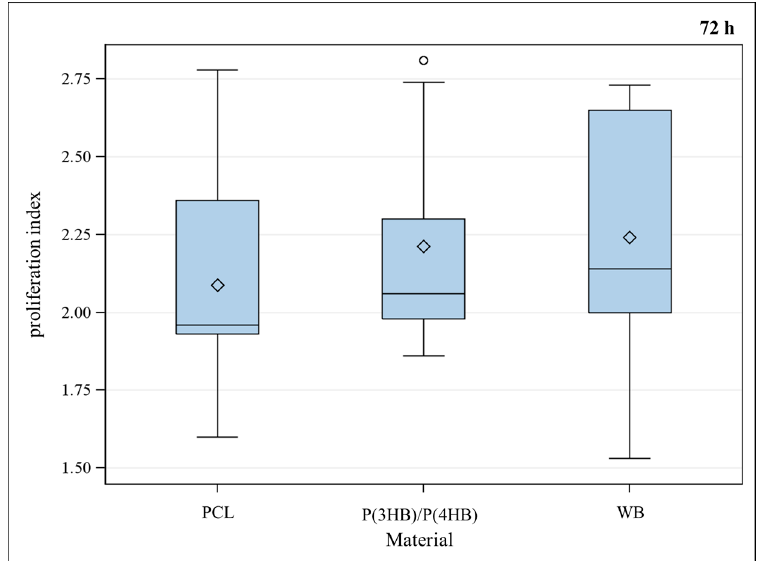
Figure 3. Proliferation index of murine osteoblasts for different materials PCL (poly- ε -caprolactone), P(3HB)/P(4HB) (poly(3-hydroxy-butyrate)/poly(4-hydroxy-butyrate)) and WB (well bottom). No